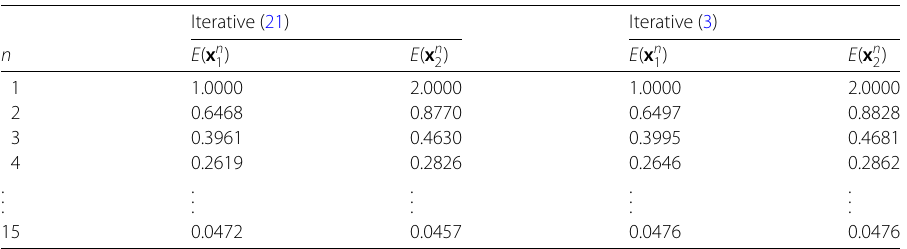
Table 1 Detailed analysis of computational methods (21) and (3) for Example 1 with u = (5,5), ) = (cid:4) x n +1 N = 15, E ( x n 1 1